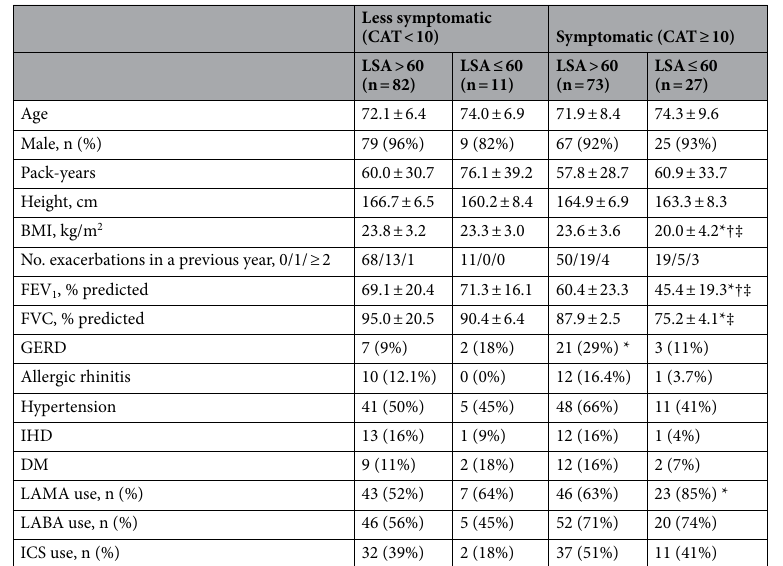
Table 2. Clinical and physiological comparisons between subgroups defined based on symptoms and physical activity questionnaires. Data are expressed as mean ± SD and n (%). Based on scores of COPD assessment test (CAT) and Life-Space Assessment (LSA) questionnaires, patients were divided into 4 groups. IHD = ischemic heart disease, GERD = gastroesophageal reflex disease, DM = diabetes mellitus, LAMA = long-acting muscarinic antagonist, LABA = long-acting beta agonist, ICS = inhaled corticosteroid. * p < 0.05, †p < 0.05, and ‡ p < 0.05 compared to patients with CAT < 10 and LSA > 60, to those with CAT < 10 and LSA ≤ 60, and to those with CAT ≥ 10 and LSA > 60, respectively, based on the Tukey’s method for continuous variables and Fisher’s exact tests with Bonferroni correction for categorical variables.